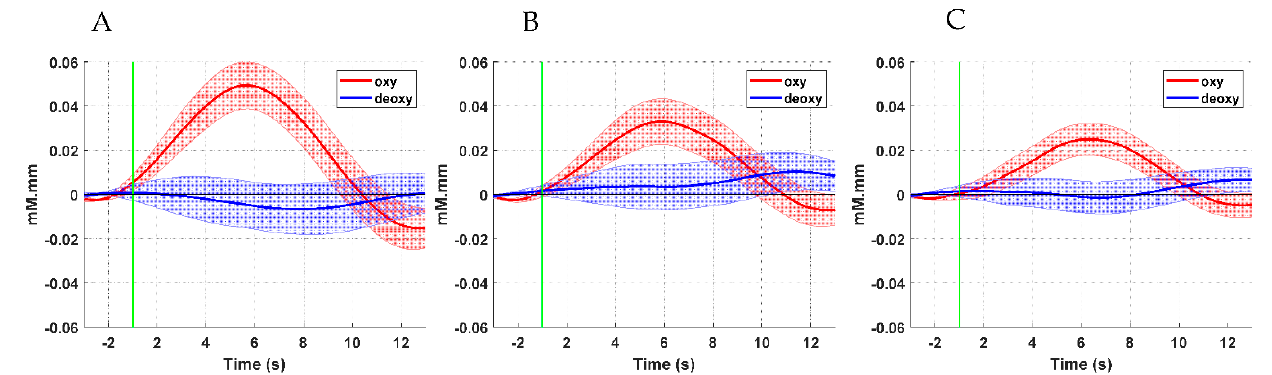
Figure 6. Time course of the averaged oxyHb and deoxyHb of the selected channels with respect to the motor cortex areas during right ankle joint movement: ( A ) LPMCdr, ( B ) LPMCvr, and ( C ) LPMA.